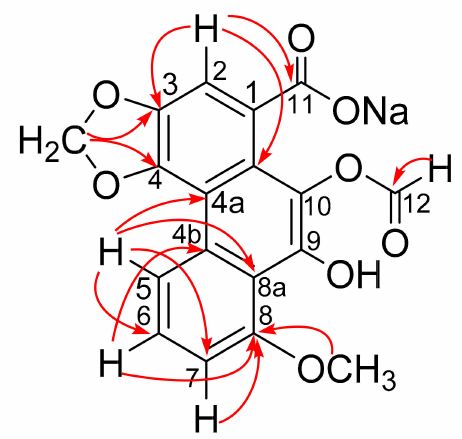
Figure 2. HMBC correlation (H → C) for compound 9